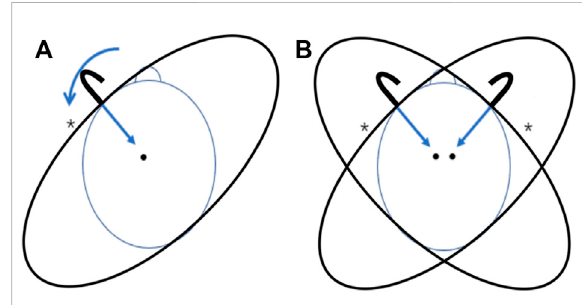
FIGURE 1 The unilateral and bilateral HR. (A) Unilateral HR on the left side, the hanger was placed on the left frontal-temporal area; (B) BilateralHR,twohangerswereplacedonbothsidesofthefrontal- temporal areas; *, the compressed side of